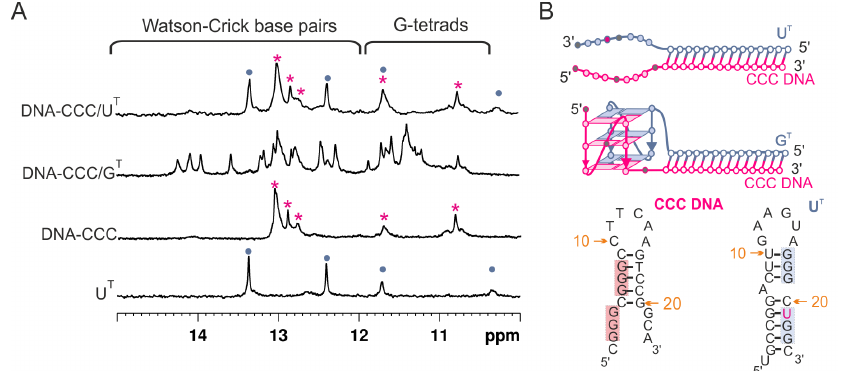
Figure 4. The imino region of the 1 H NMR spectra of DNA-CCC/U T , DNA-CCC/G T , DNA-CCC, and U T , recorded in 90% H 2 O/10% D 2 O ( v / v ) in the presence of 50 mM KCl, 10 mM potassium phosphate, and 0.1 mM EDTA, pH 6.8; 25 °C ( A ). Red stars–imino signals of DNA-CCC, blue dots–imino signals of U T . Proposed secondary structures (2Q, QDH, Dss) and predicted by RNAstructure (hairpins, DX) ( B ).